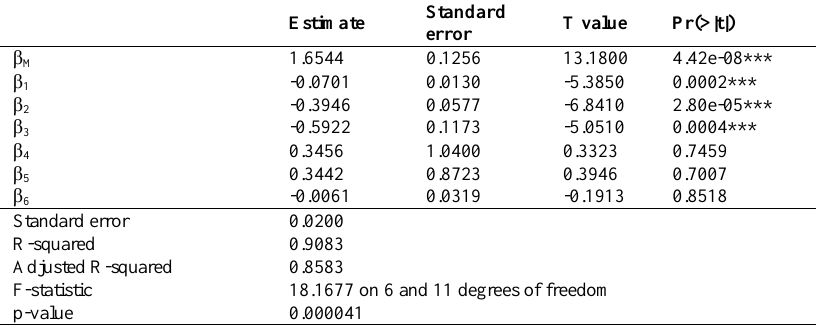
Table 2. The results of the regression analysis of Russian small and medium manufacturing enterprises in years